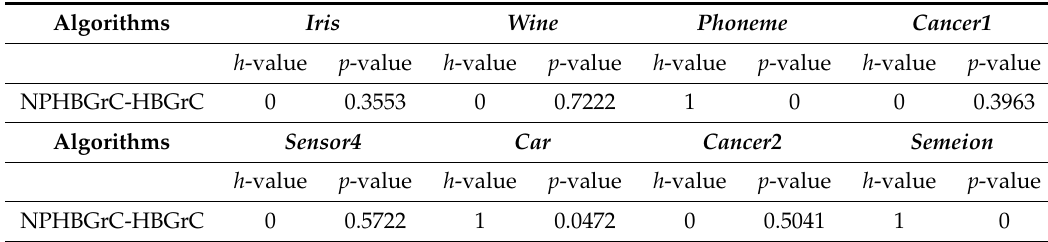
Table 4. The t -test values of comparison of NPHBGrC and HBGrC.